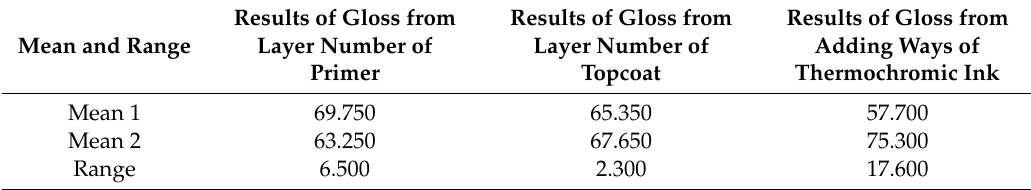
Table 7. Range of the gloss of